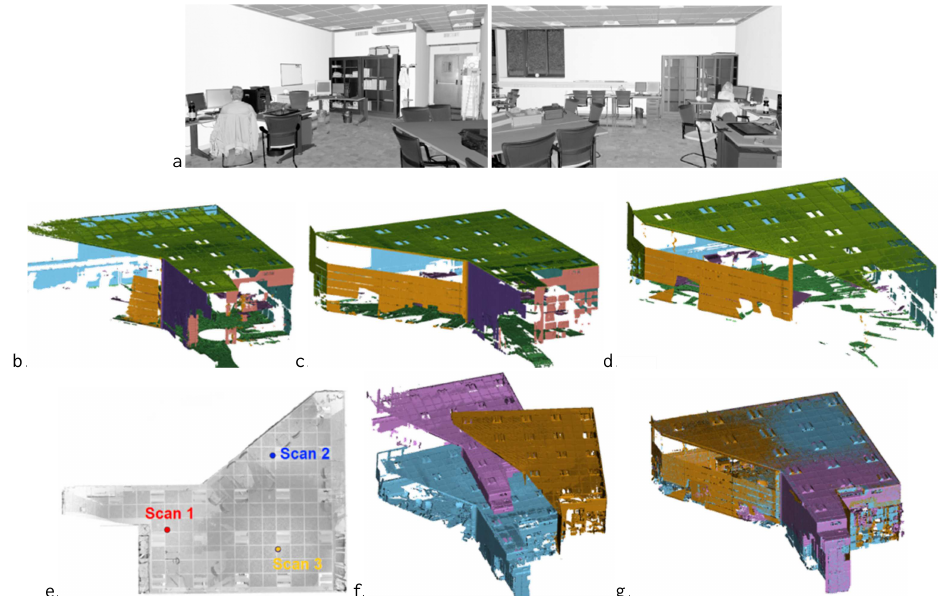
Figure 5. ‘Office room’ data set registration results. An overview of the office room (a); segmentation results for Scan 1 (b), Scan 2 (c) and Scan3(c), where corresponding segments are represented with the same colour; estimated positions of scan stations (e); and scan alignment before (f) and after the registration